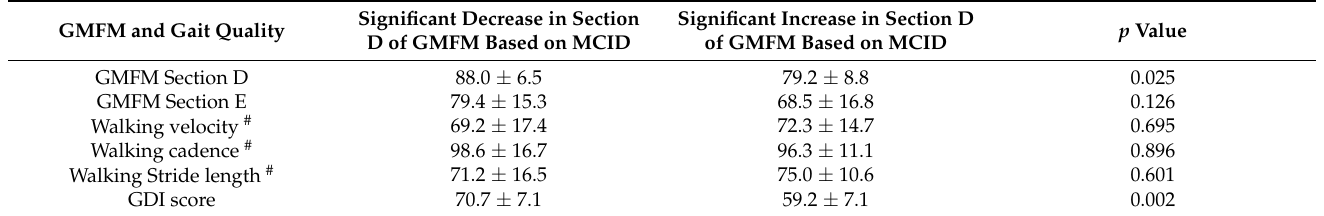
Table 5. Mean barefoot values for gait quality and GMFM scores based on significant changes in Sections D and E of GMFM with use of